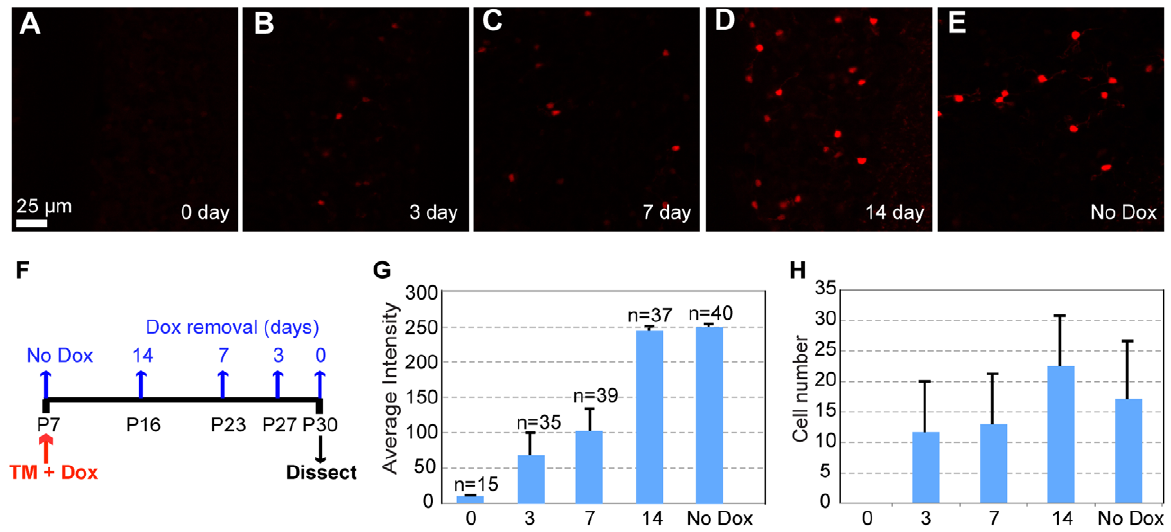
Figure 2. Dox-dependent gene activation. (A–E) Representative confocal images of labeled cerebellar GCs from P30 triple transgenic mouse (ZtTA/wt; TRE-Bi-SG-T/wt; b -actin-CreER/wt). Tamoxifen was injected at P7 and Dox was never administered (E) or it was removed for 0 (A), 3 (B), 7 (C) or 14 (D) days. Scale bar=25 m m. (F) Diagram of the experimental procedure described above. (G) Quantification of the average fluorescence intensity in cerebellar GC bodies indicates that the expression level of the TRE-driven transgene increases the earlier Dox is removed, reaching maximal expression by 14 days after Dox removal. Error bars represent standard deviation. ‘‘n’’ represents the number of analyzed cell bodies for each condition indicated. Two animals per Dox condition were used for analysis. (H) Quantification of the total number of labeled cerebellar GCs per 225 6 225 m m 2 for each Dox condition shows no statistically significant differences between different conditions. Error bars represent standard deviation.